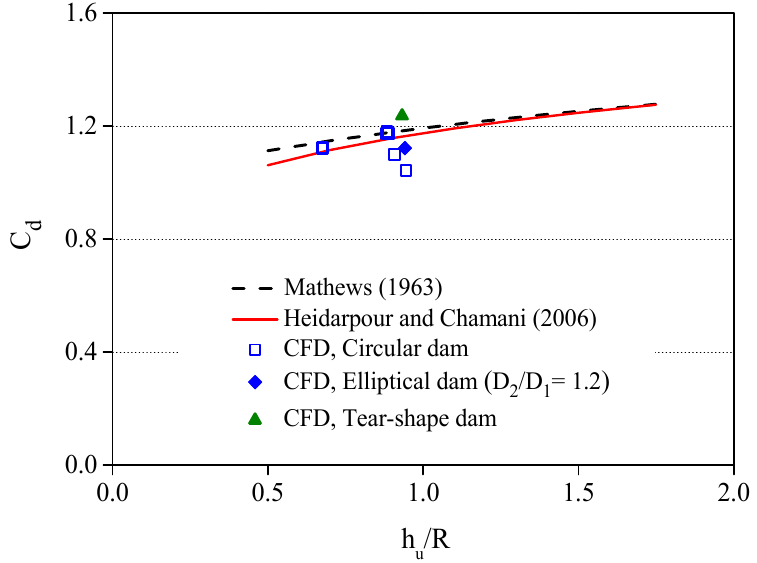
Figure 13. Relationship between the discharge coefficient and upstream water head of different dam shapes, R = D 1 /2 is the radius of the dam.